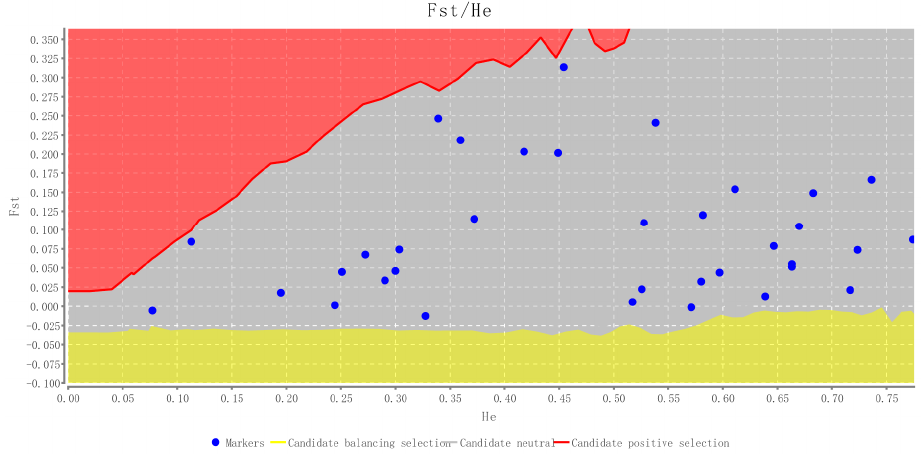
Figure 1. Potential candidates for selection. Loci located in the red region are candidates for positive selection, grey region for neutral, and yellow region for balancing selection. All of the 35 loci are under neutral expectations.